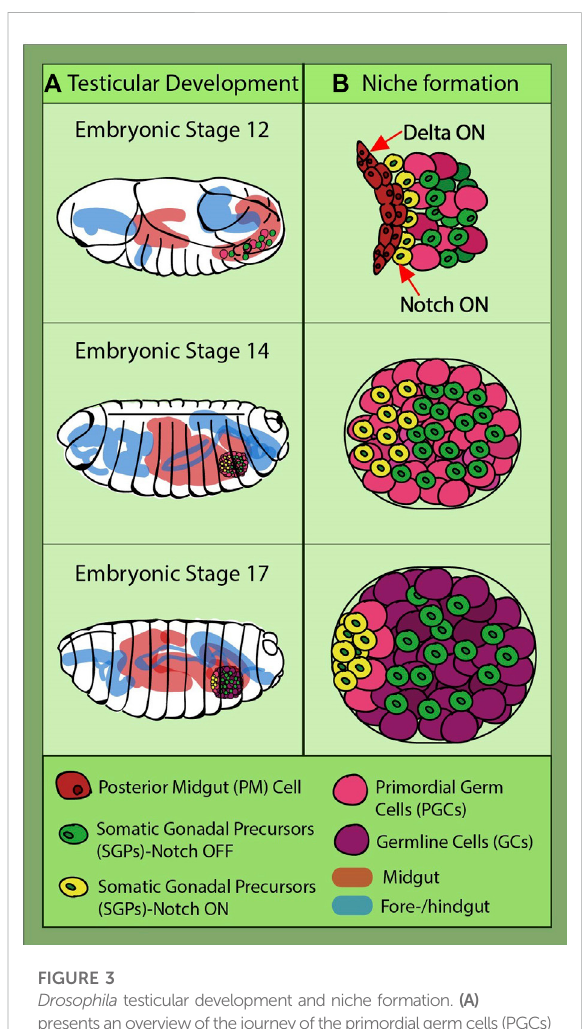
FIGURE 3 Drosophila testicular development and niche formation. (A) presentsanoverviewofthejourneyoftheprimordialgermcells(PGCs) (pink)andsomaticgonadalprecursors(SGPs)(greenandyellow)which takes place during embryonic stages 12 – 17, the last one before hatchingintoalarva.Theyarestrungalongtogetherwiththeposterior midgut (PM); at stage 14, they leave the gut, coalesce, and go on to organize themselves into two round gonads. (B) depicts the direct interaction between the PM cells and some of the SGPs (yellow), this being the moment when their fate is sealed through Notch induction causedbytheDelta-sendinggutcells.Notch-activeSGPswillgoonto form the germline niche and recruit GSCs (light